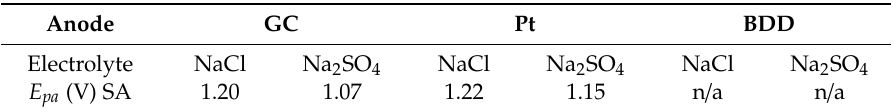
Table 2. Overview of peak potentials E pa (V) vs. Ag/AgCl (3M) for different anode materials and supporting electrolytes (scan rate: 1 V/s) .